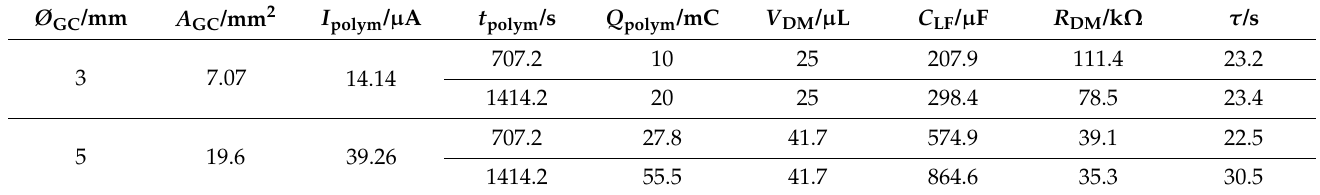
Table 2. The low-frequency capacitance ( C LF ), bulk resistance ( R DM ) and time constant ( τ ) values calculated from the EIS spectra of the fabricated GC/PEDOT:PSS/DM electrodes.